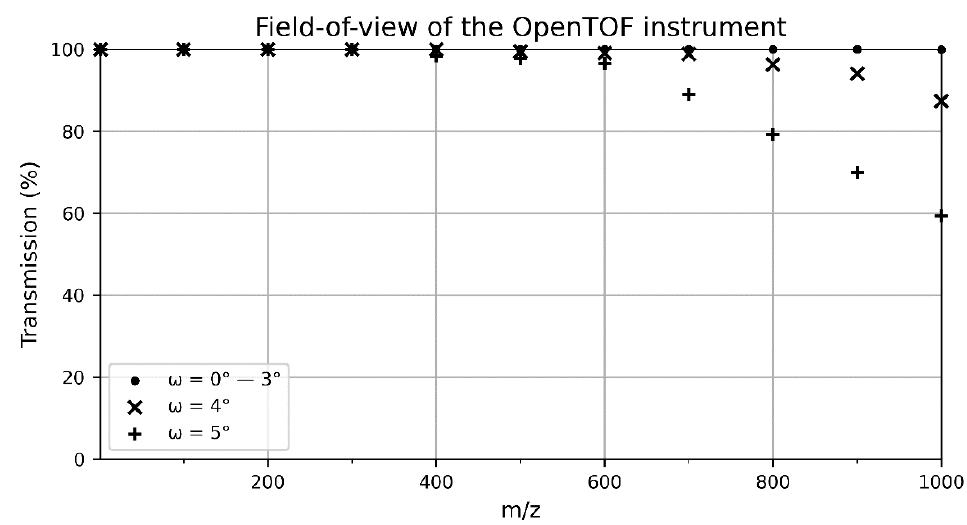
Figure 2. The transmission of this instrument is 1 in a cone half-angle ω of smaller than 3°. For larger cone half-angles, the transmission decreases so that the reliable mass range has to be shortened.